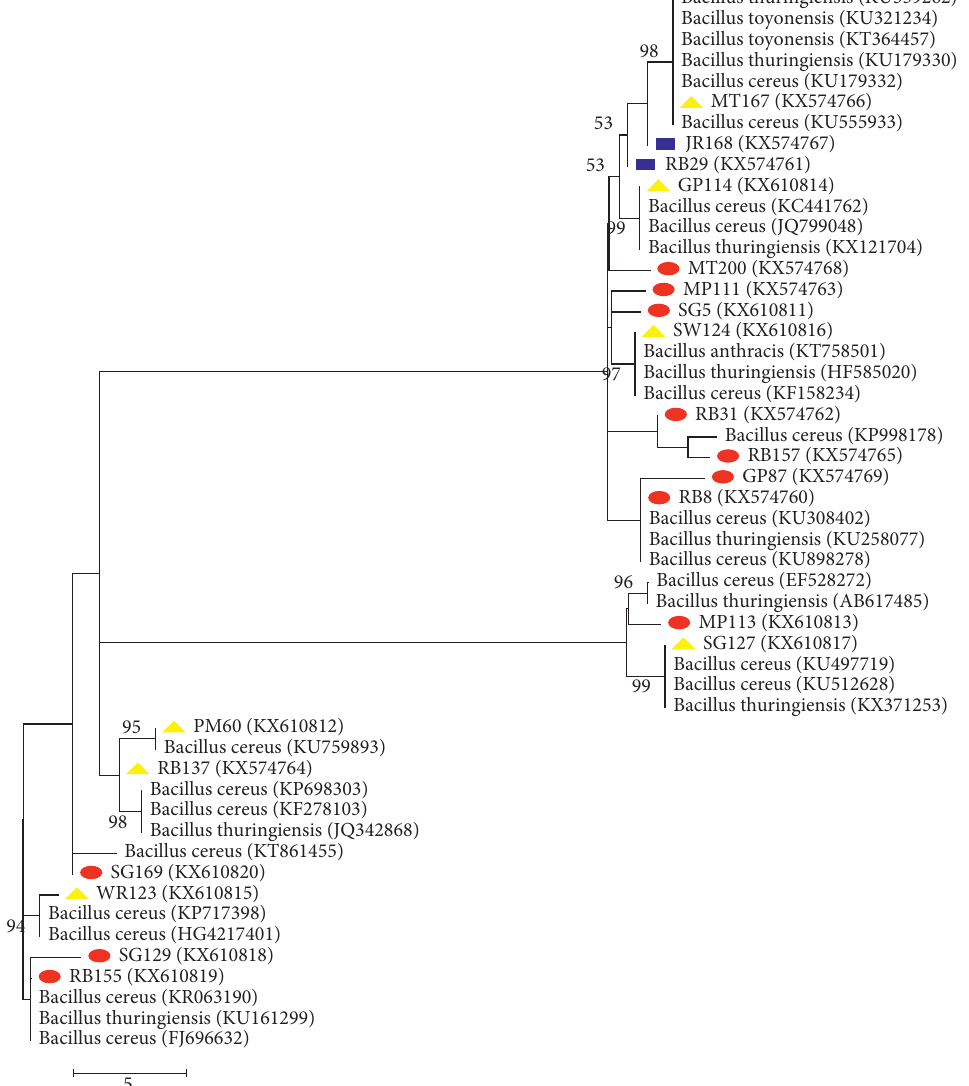
Figure 4: Maximum Likelihood phylogenetic tree based on partial 16S rDNA gene sequence, showing the phylogenetic relationships between the Bacillus cereus and the most closely related strains from GenBank. Sequences obtained in this study higher than 90% are denoted with the yellow triangle, greater than 50%, but lower than 80% with the blue rectangle and less than 50% with a red